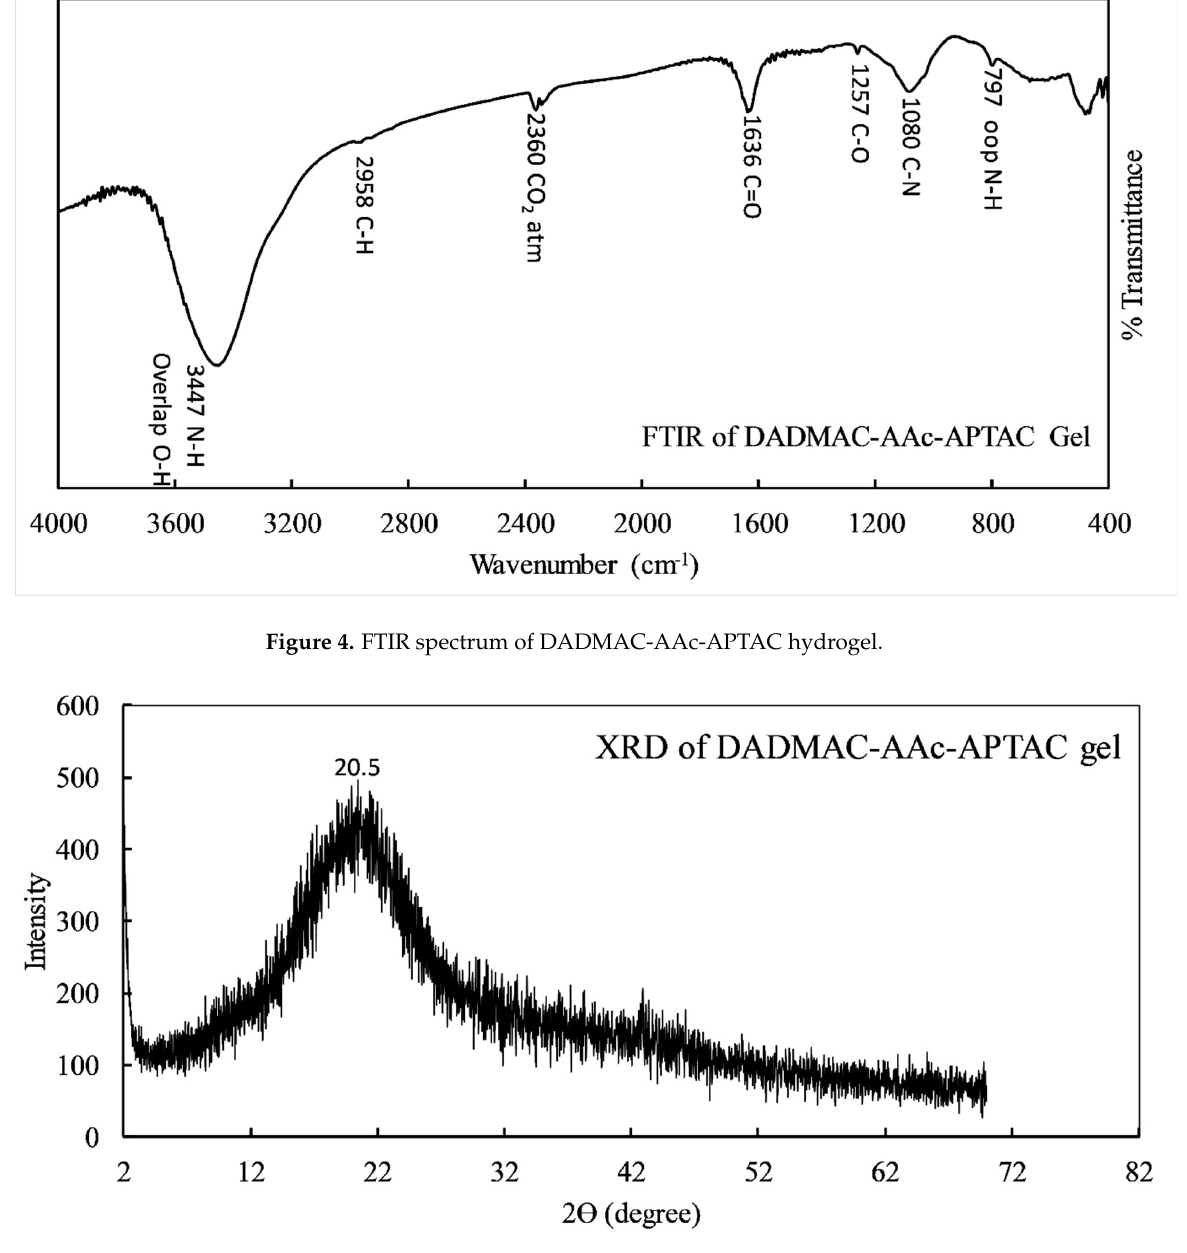
Figure 4. FTIR spectrum of DADMAC-AAc-APTAC hydrogel.